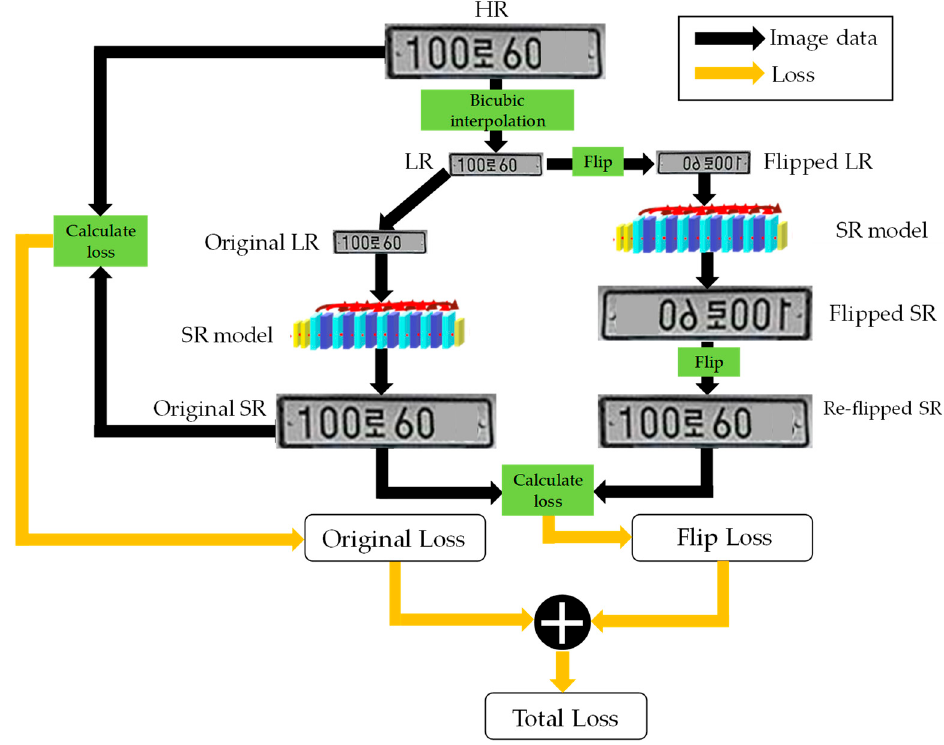
Figure 3. Proposed loss function for the SR framework. Two characters were masked due to privacy policies. privacy